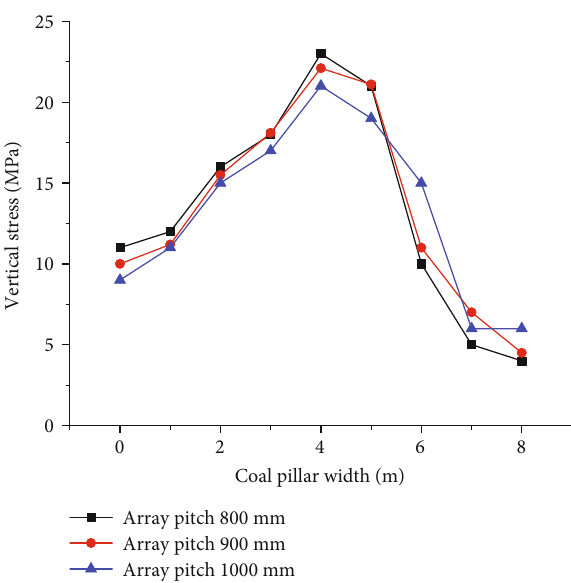
Figure 14: Vertical stress distribution law in 8 m width coal pillar under the condition of di ff erent bolt (cable) support row